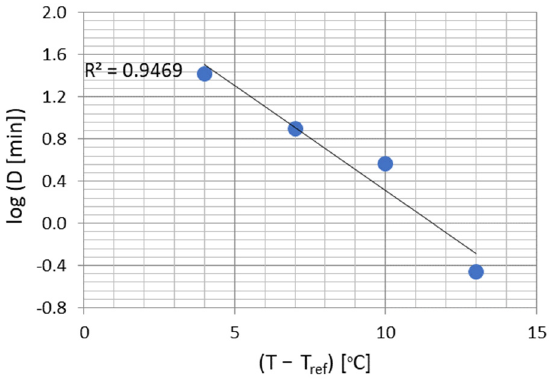
Figure 1. D values of S. Typhimurium in alheira batter against temperature difference, showing adjusted Bigelow equation line and coefficient of determination; T ref = 50 °C.